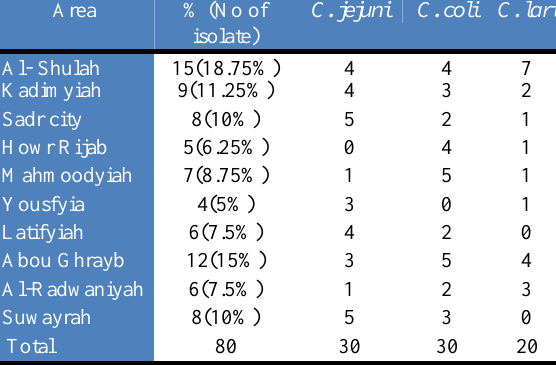
4: Distribution of Campylobacter spp. according to locations in Baghdad